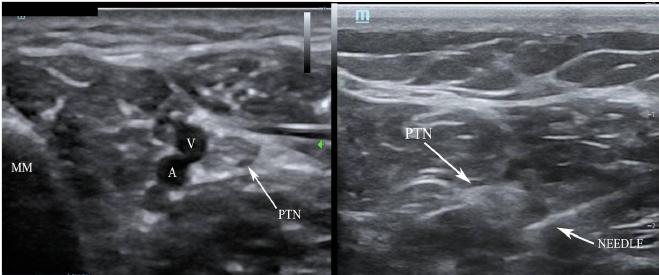
Image 3. Posterior tibial nerve (PTN) block. Left demonstrates anatomical landmarks of the medial malleolus (MM), vein (V) and artery (A). Right, the needle with anesthetic spread around the PTN coming from a posterior